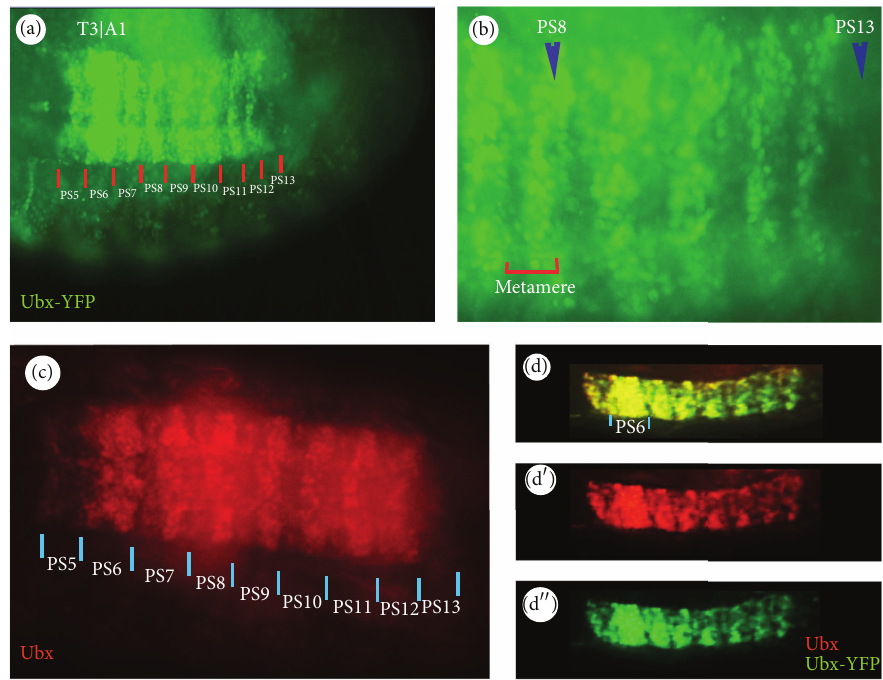
Figure 2: Metameric and heterogeneous pattern of Ubx expression in the CNS. (a) Ubx-YFP expression pattern in the Stage 16 embryo as detected with 𝛼 -GFP in Ubx CPTI000601 . Labelling is very prominent in PS6. (b) A magnified view of a part of the embryo shown in (a) demonstrating nuclear staining in metameres with PS8 and 13 highlighted. Both (a) and (b) are ventral views with anterior to the left. (c) Endogenous Ubx expression pattern as revealed by staining the wild type with mouse 𝛼 -Ubx antibody. ((d)–(d 󸀠󸀠 )) Double staining of Ubx- YFP and its endogenous gene using 𝛼 -GFP and 𝛼 -Ubx antibodies, respectively, in the CNS of Ubx CPTI000601 embryos. The protein trap and overall Ubx labelling have very similar temporal and spatial expression